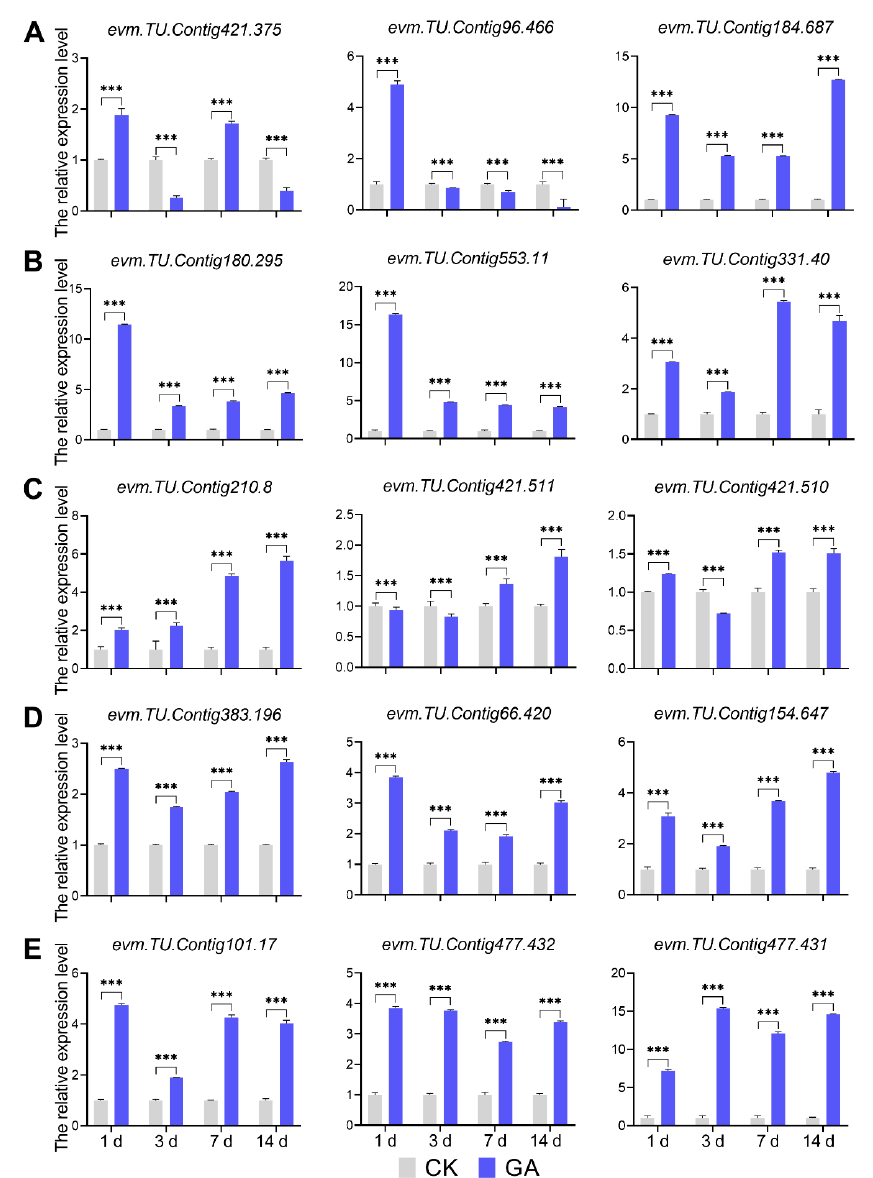
Figure 8. The analysis of DEGs from different pathways by qRT-PCR. ( A ) qRT-PCR-based the rela- tive expression level analysis of genes involved in the GA biosynthesis pathway. ( B ) qRT-PCR-based